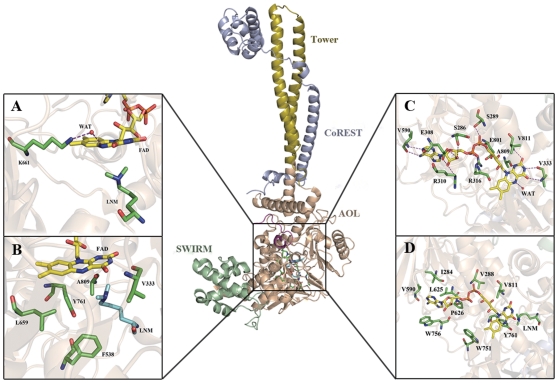
The overall structure of LSD1-CoREST-substrate complex and key interactions in the catalytic chamber.Cartoon diagram of the LSD1-CoREST-substrate complex highlights the SWIRM domain (green), AOL domain (wheat), Tower domain (golden yellow), CoREST (light blue) and substrate peptide (magenta). (A) H-bond interactions in the conserved lysine-water-flavin motif. The bridging water molecular is shown in red sphere and the residues and FAD are shown in green and yellow sticks, respectively. H-bonds are indicated with purple dashed lines. (B) Hydrophobic interactions of dimethylated H3K4 with its surrounding residues in the catalytic chamber. Dimethylated H3K4 is shown in cyan for the sake of clarity. (C) H-bond interactions of FAD with its surrounding residues. (D) Hydrophobic interactions of FAD with its surrounding residues.